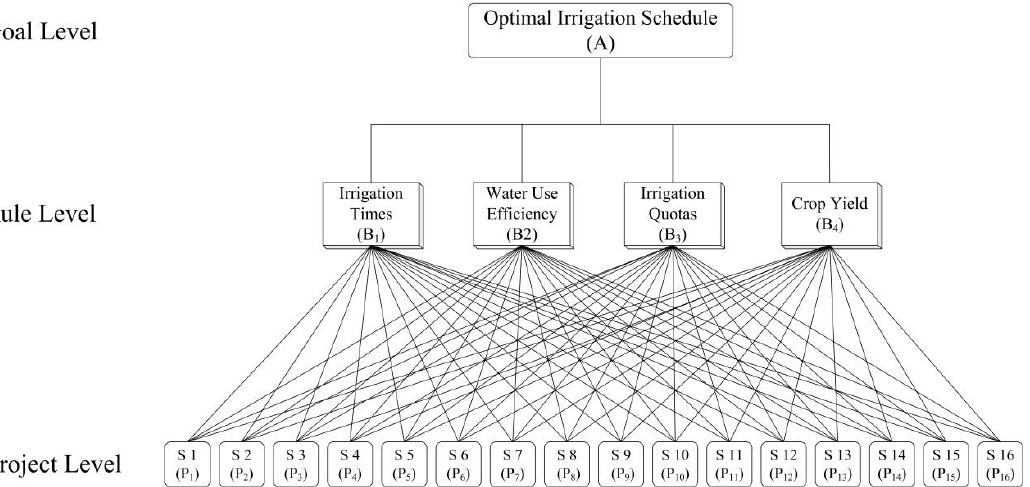
Figure 8. Hierarchy diagram.